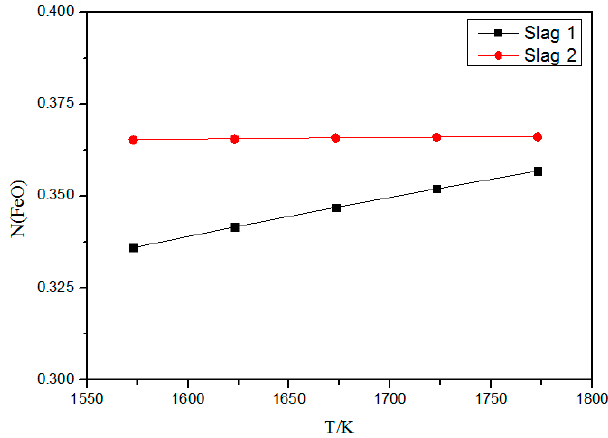
Figure 2. Effect of temperature on activity of FeO.